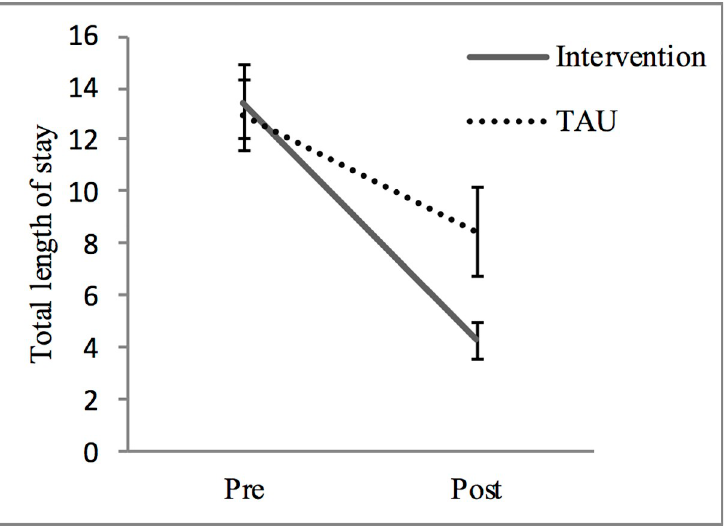
Fig 2. Difference in the average number of days (per patient) spent in the inpatient unit in the 18 months baseline (pre) and in the 18 months active intervention (post) of stepped care (n = 335) vs. TAU (n =